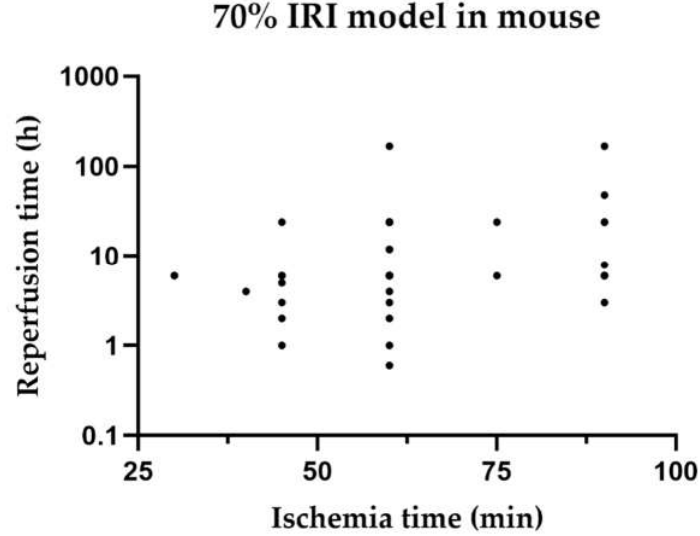
Figure 4. Distribution of reperfusion times compared with their ischaemia times in 70% ischaemia models in mice. Studies with various reperfusion times are listed for each individual time point. Time points are listed regardless of the survival time of animals. Table 5. Other mouse models not included in the meta-analysis.